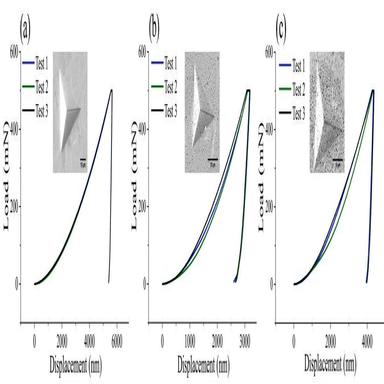
Load-displacement profiles of the sample along with the examples of the indent footprint. (a) Three load-displacement profiles of the SPS_Cu sample. Three profiles show a similar behavior in terms of profile shape and magnitude of the residual displacement. (b) Three load-displacement profiles of the SPS_Cu3B sample taken from the data, which are close to the average hardness value. (c) Three load-displacement profiles of the Arc_Cu3B sample selected from the data, which are close to the average hardness